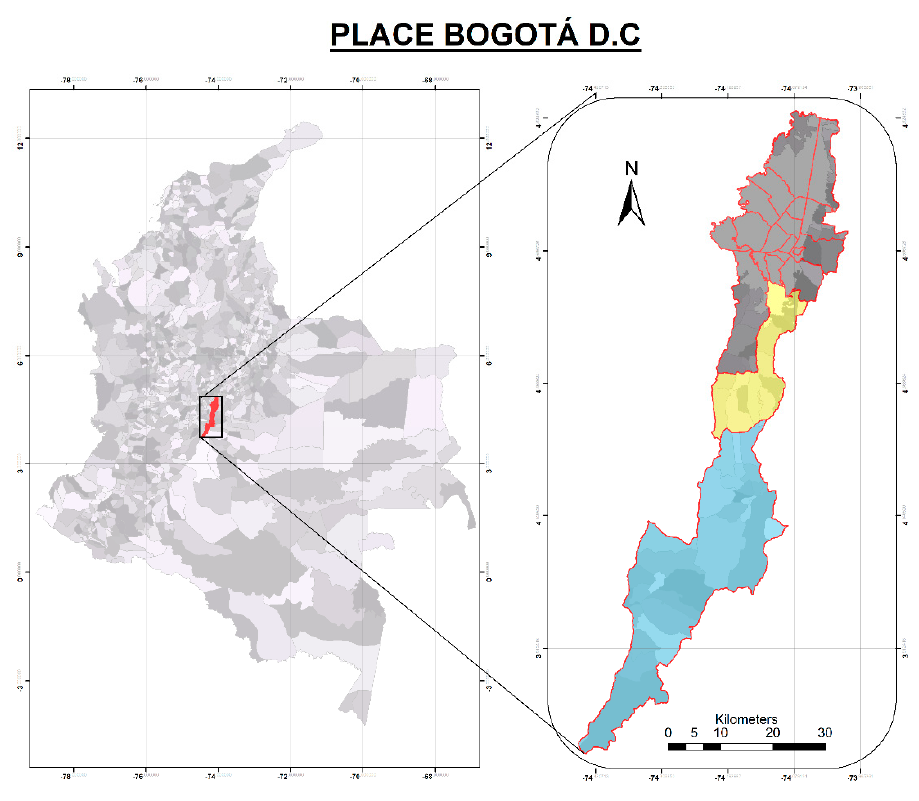
Figure 1. The map of the Localities of the city of Bogotá.